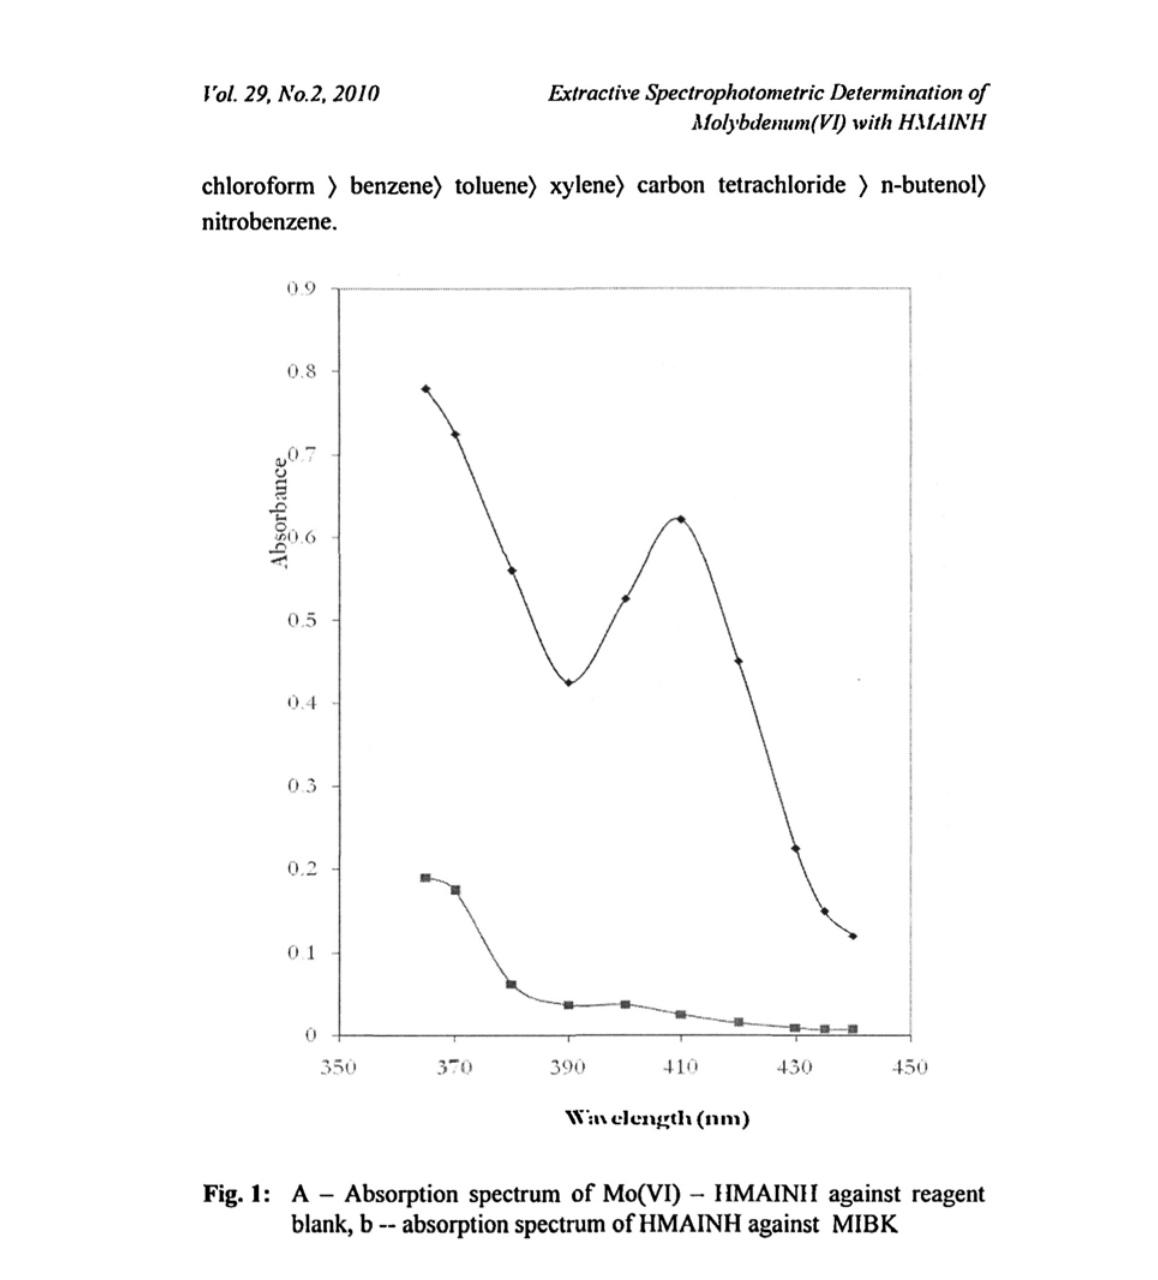
Fig. 1: A — Absorption spectrum of Mo(VI) — I IMAINII against reagent blank, b — absorption spectrum of HMAINH against